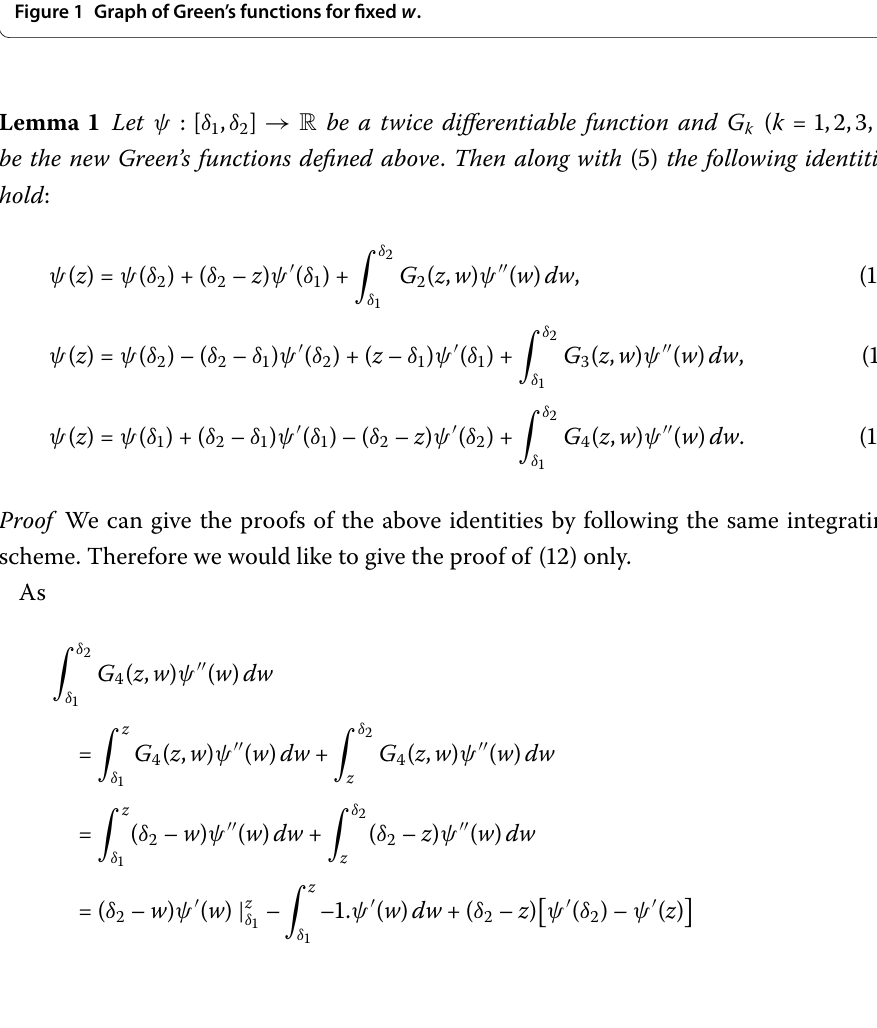
Figure 1 Graph of Green’s functions for fixed w